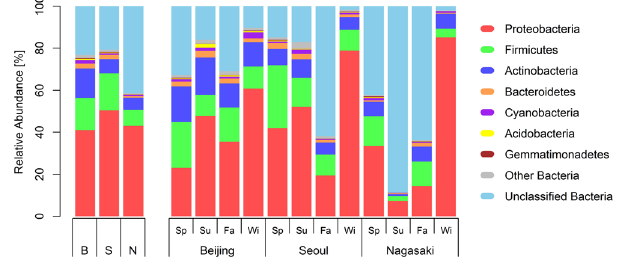
Figure 1. Relative abundance of airborne bacteria at the phylum level at each measurement site during the measurement period. B, S, and N indicate the Beijing, Seoul, and Nagasaki sites, respectively, and Sp., Su., Fa., and Wi. indicate the four seasons (spring, summer, fall, and winter, respectively).